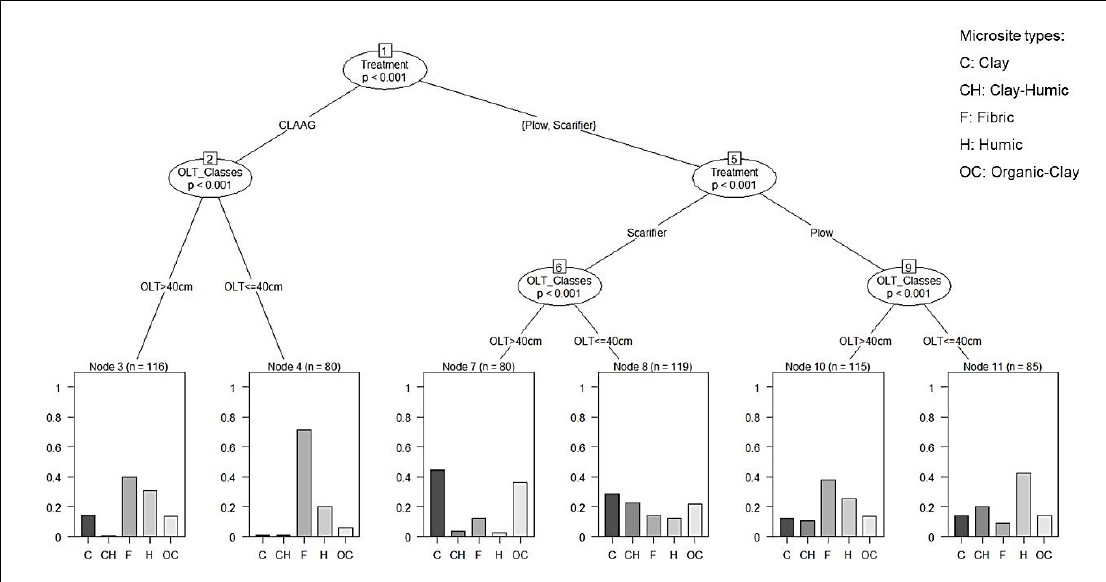
Figure 2. Main types of microsites found at the study site. Forests 2019 , 10 , x FOR PEER REVIEW